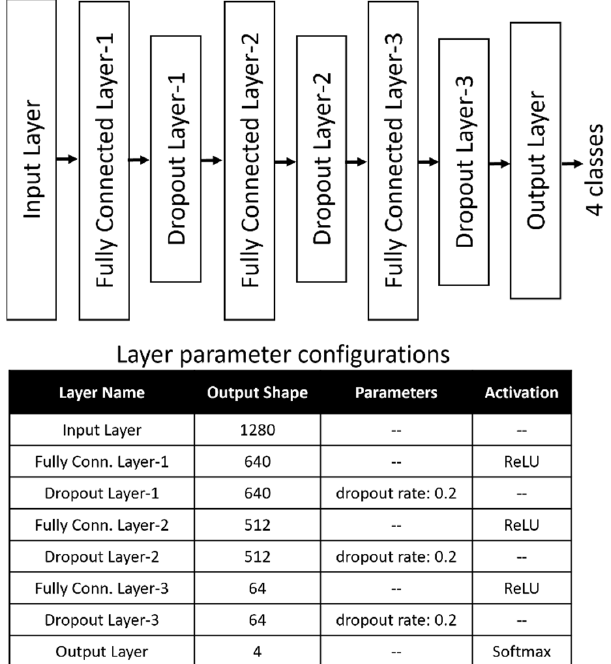
Figure 5. Deep neural networks for emotion estimation based on emoticons and sentences (using five types of features).